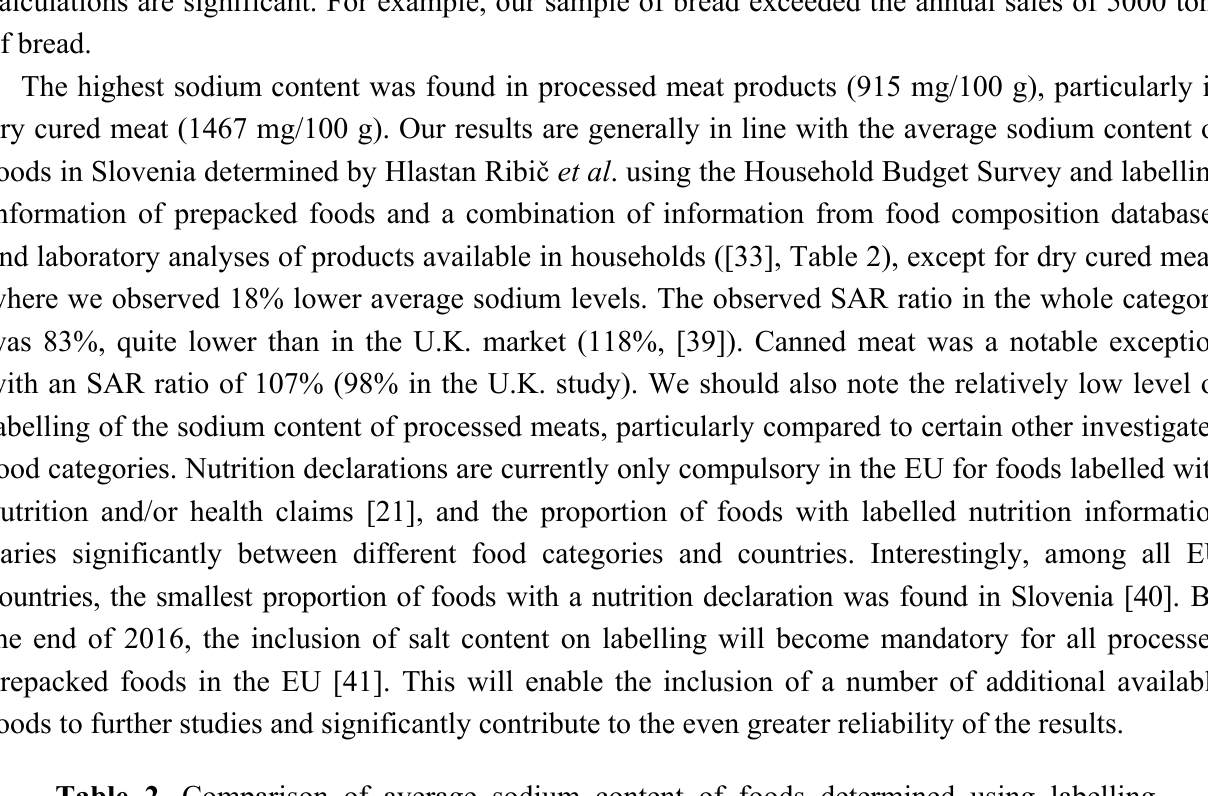
Table 2. Comparison of average sodium content of foods determined using labelling information of sold prepacked foods (SCS) and a combination of information from food composition databases and laboratory analyses of products available in